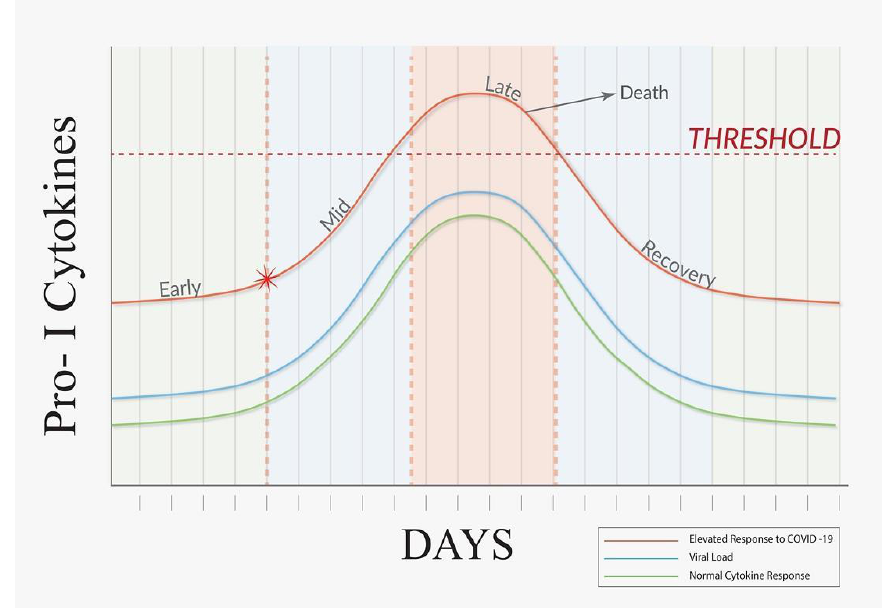
Figure 1. The Critical Point in Care (Graph by Dr. Clawson,